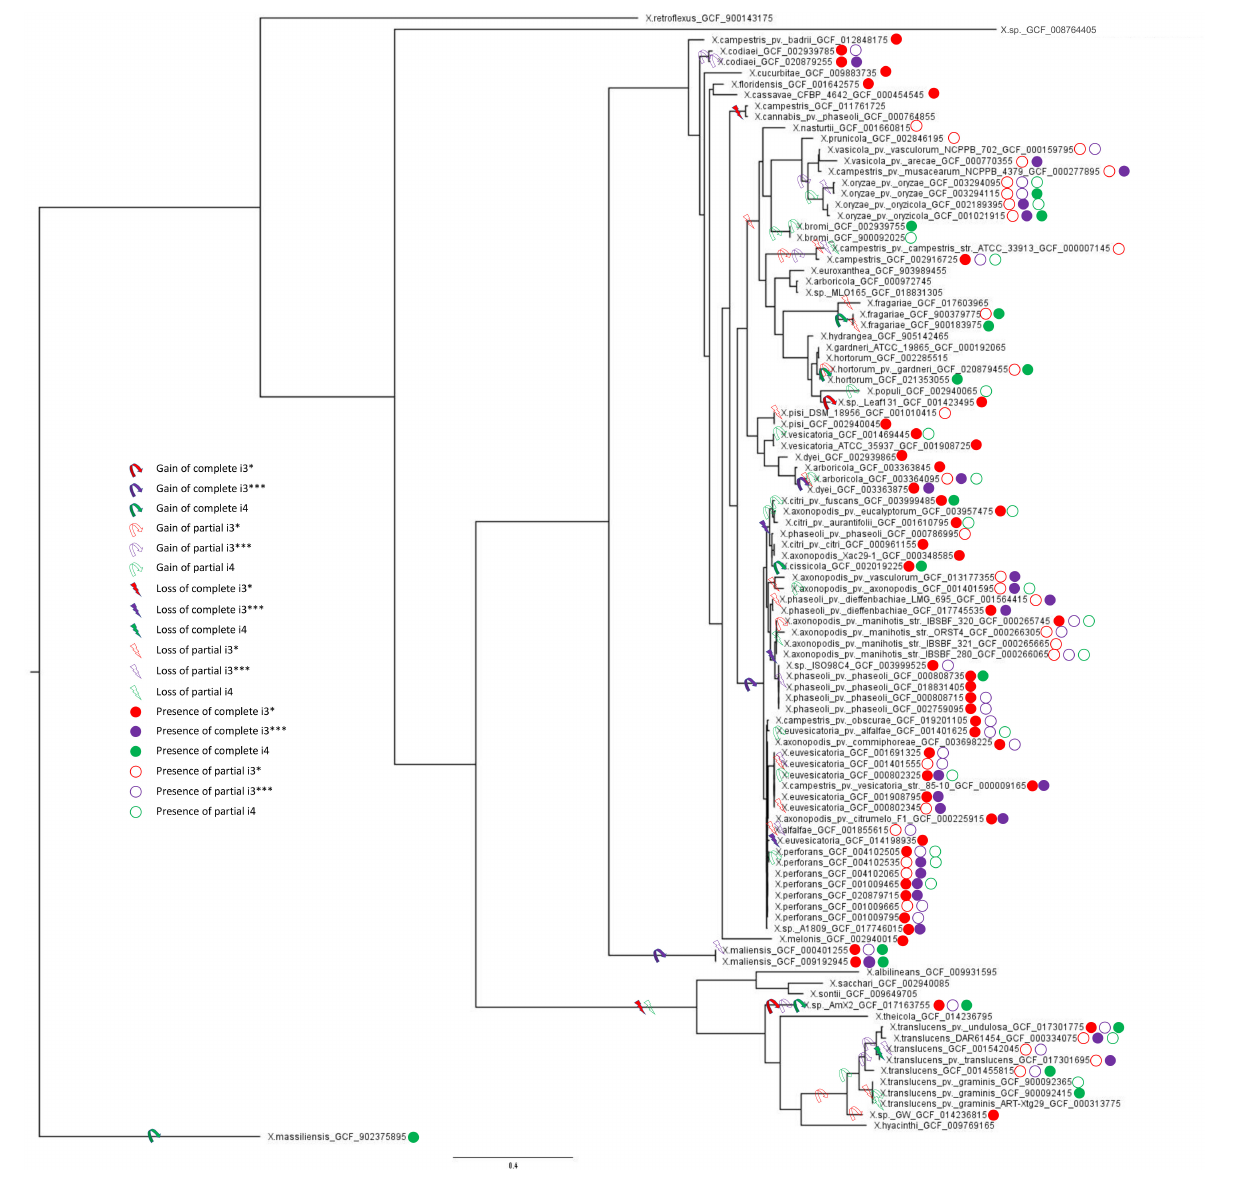
FIGURE 3 | Multilocus sequence analysis phylogenetic tree and T6SS clusters presence/absence and gain/loss prediction for the genus Xanthomonas. Gain and loss of individual T6SS genes were mapped onto the MLSA phylogeny of 1,740 Xanthomonas spp. From each species, one genome with each phyletic pattern was included; that is, if two or more genomes from the same species had identical presence/absence profile of T6SS genes, only a single representative was included in the analysis. The tree was rooted using X. massiliensis as outgroup. The presence of complete and partial T6 clusters (i3 ∗ , i3 ∗∗∗ , and i4) in all the strains was taken from Table 1 . Ancestral gain and loss events were mapped onto the tree based on the output of GLOOME. For all the predicted events, the probability was higher than